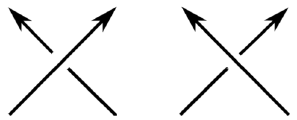
Figure 12. A crossing in a projection of a protein can be assigned a positive (Left) or negative (Right) sign, depending on the